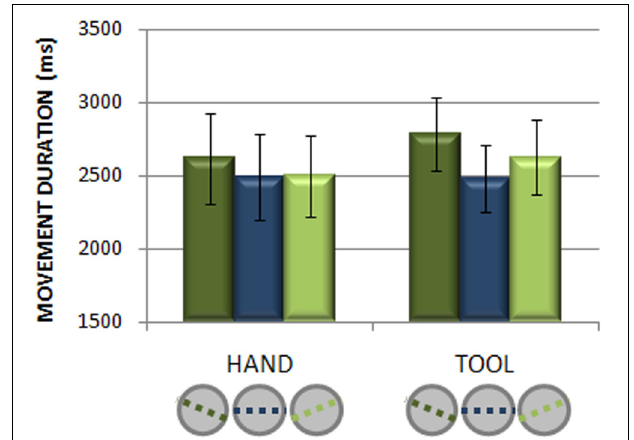
FIGURE 3 | Imagined movement duration. The graph displays the average imagined movement duration as a function of effector (hand and tool) and orientation of the Opposition Axis ( − 22 ◦ ; 0 ◦ ; + 22 ◦ ). Bar graphs illustrate mean values for each parameter ± 1